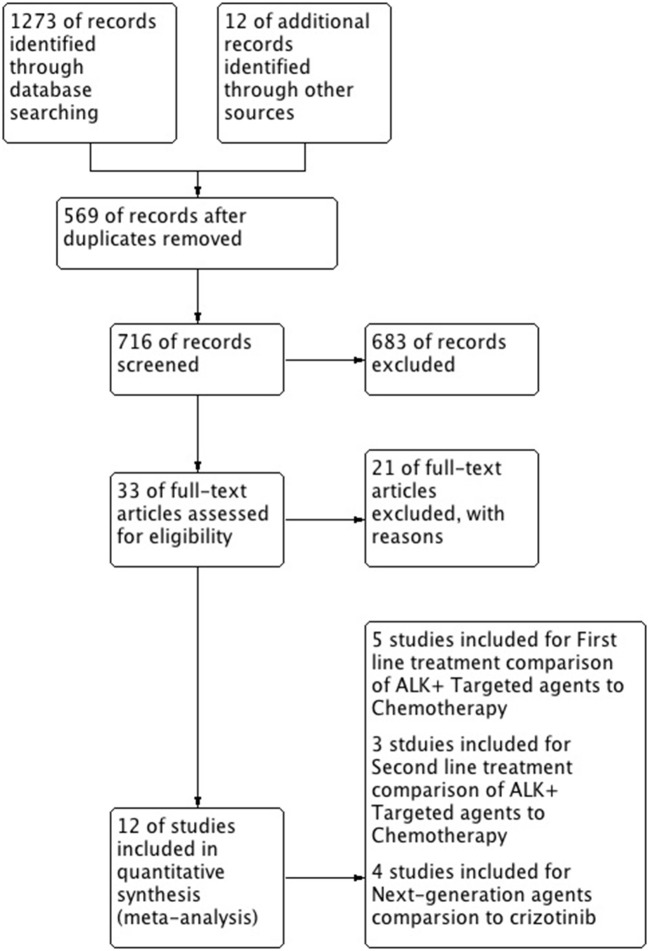
The flow diagram of literature search and selection process.